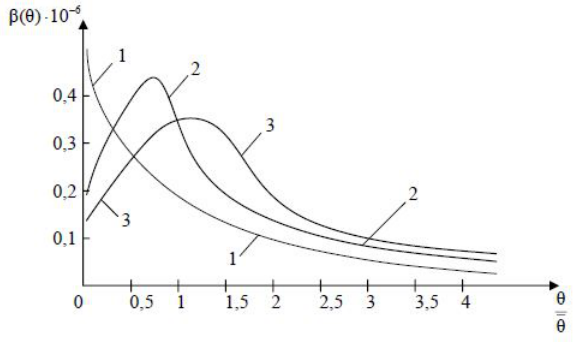
Figure 2 . Dependences of the distribution functions of the duration of preventive examinations for exponential – 1, log-normal – 2 and truncated-normal – 3